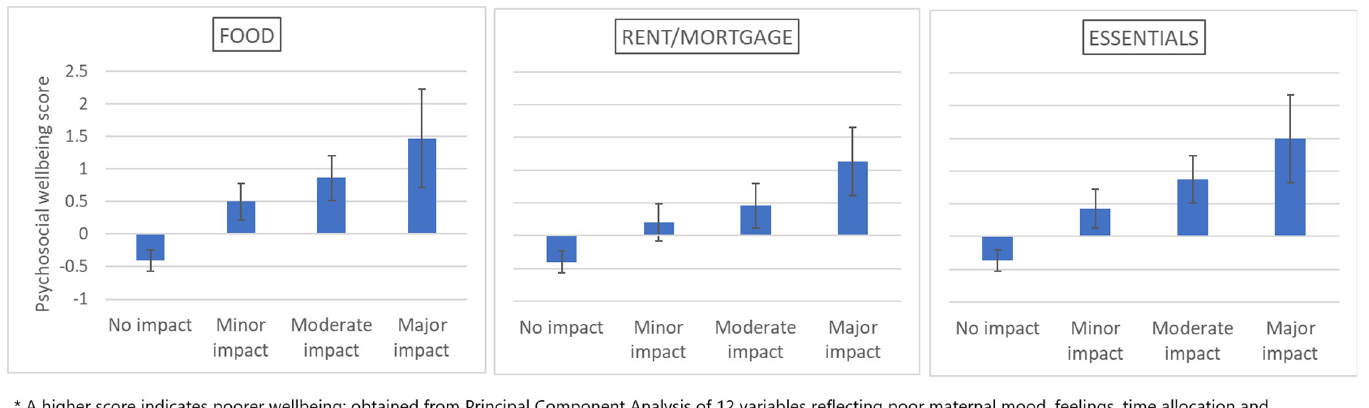
Fig 3. Maternal recent psychosocial wellbeing score by reported COVID-19 pandemic impact on household expenses in the COVID-19 New Mum Study.